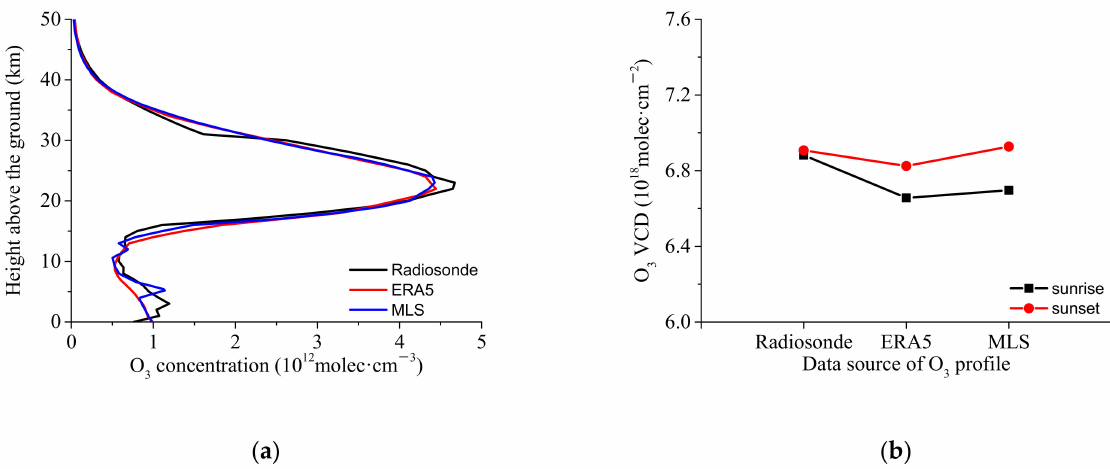
Figure 6. ( a ) Vertical profiles of the O 3 concentration from different data sources as well as ( b ) O 3 VCDs derived from the Langley plot method. The black, red, and blue curves denote the O 3 profiles derived from radiosonde soundings on 30 August 2020, from ERA5 reanalysis data and from MLS satellite observations in August 2020, respectively. Note that the default McArtim O 3 concentrations are used when there are missing values for the data sources of Radiosonde and ERA5 at specific heights (Radiosonde: >30 km; ERA5: >45 km). The black curve with squares and the red curve with dots denote the O 3 VCDs during sunrise and sunset,